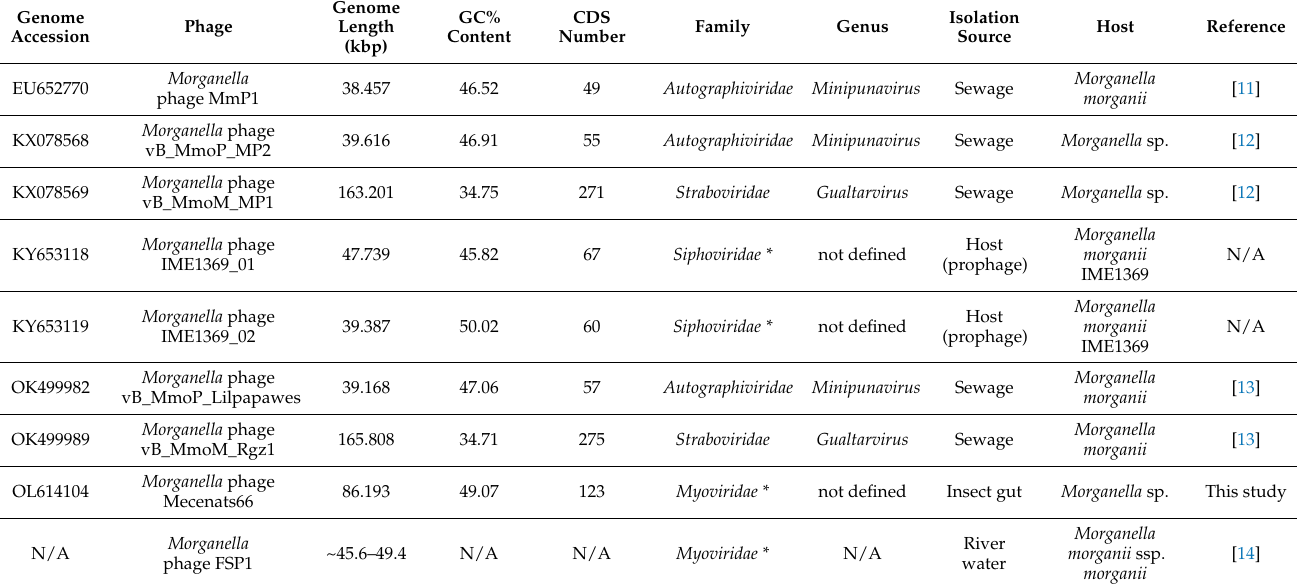
Table 1. The known Morganella -infecting bacteriophages. Family and genus columns are based on genome accession associated taxonomy. Asterisk (*) indicates viral families recently abolished by the ICTV, but either still present in the associated genome accession taxonomy at the time of writing, or indicated in the reference for phage FSP1 for which no complete genome is yet